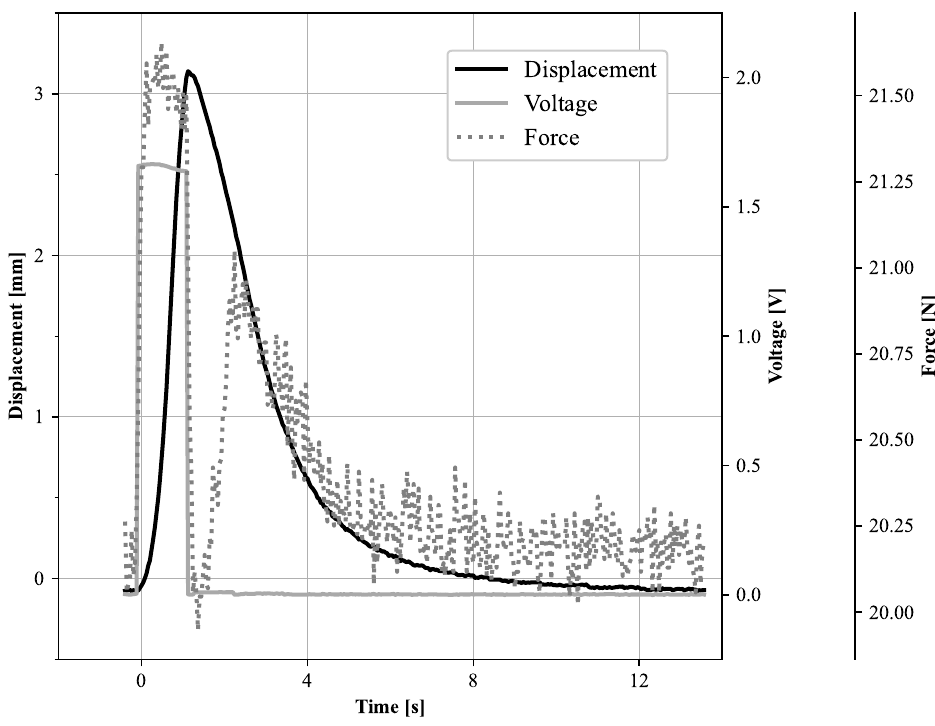
Figure 6. Measurement series of the endurance test rig showing the measured variables displacement [mm], voltage for activation [V] and force [N] over time [s]. Source: